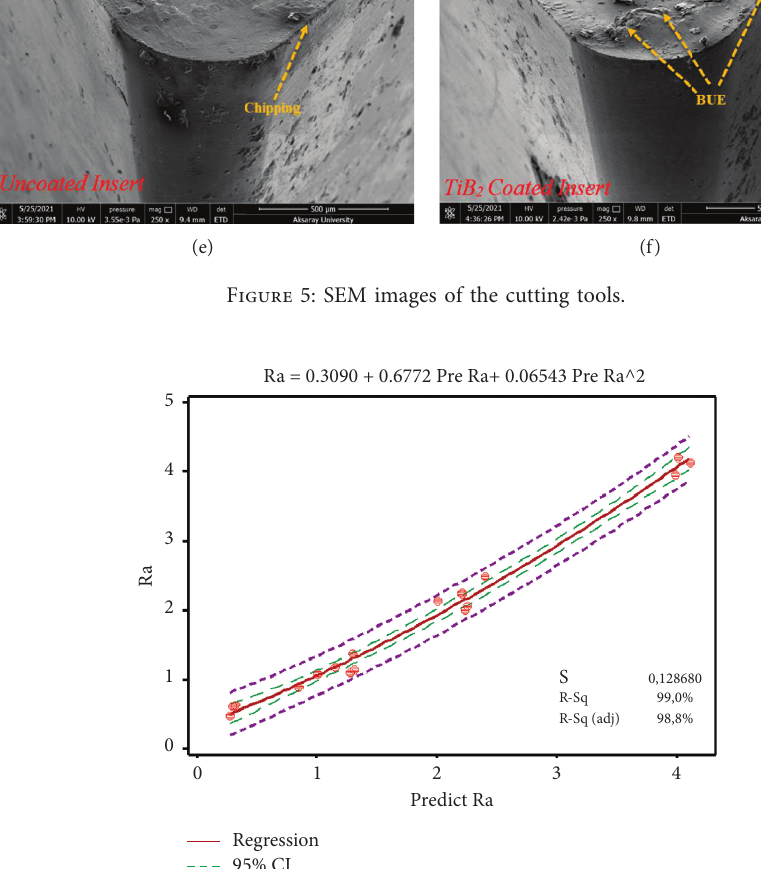
Figure 6: Comparison of actual and estimated values for